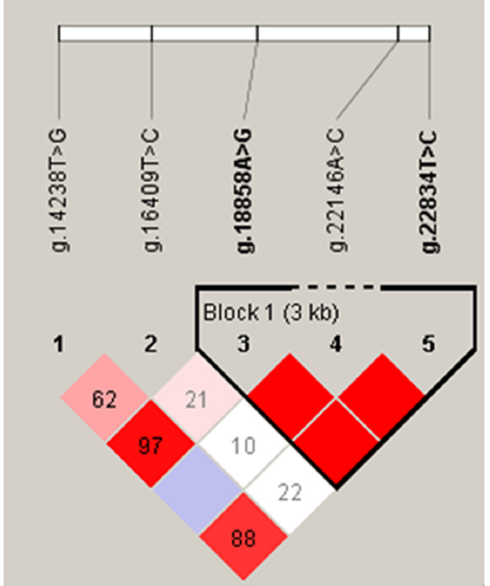
Figure 2. Linkage disequilibrium among the five SNPs of the SQLE gene. The “Block 1 (3 kb)” indicates haplotype block, and the text above the horizontal number is the SNP name. The red squares represent high pairwise linkage disequilibrium, coloring down to white squares of low pairwise linkag disequilibrium. Table 3. Association of haplotype combinations of SQLE with milk production traits in Italian